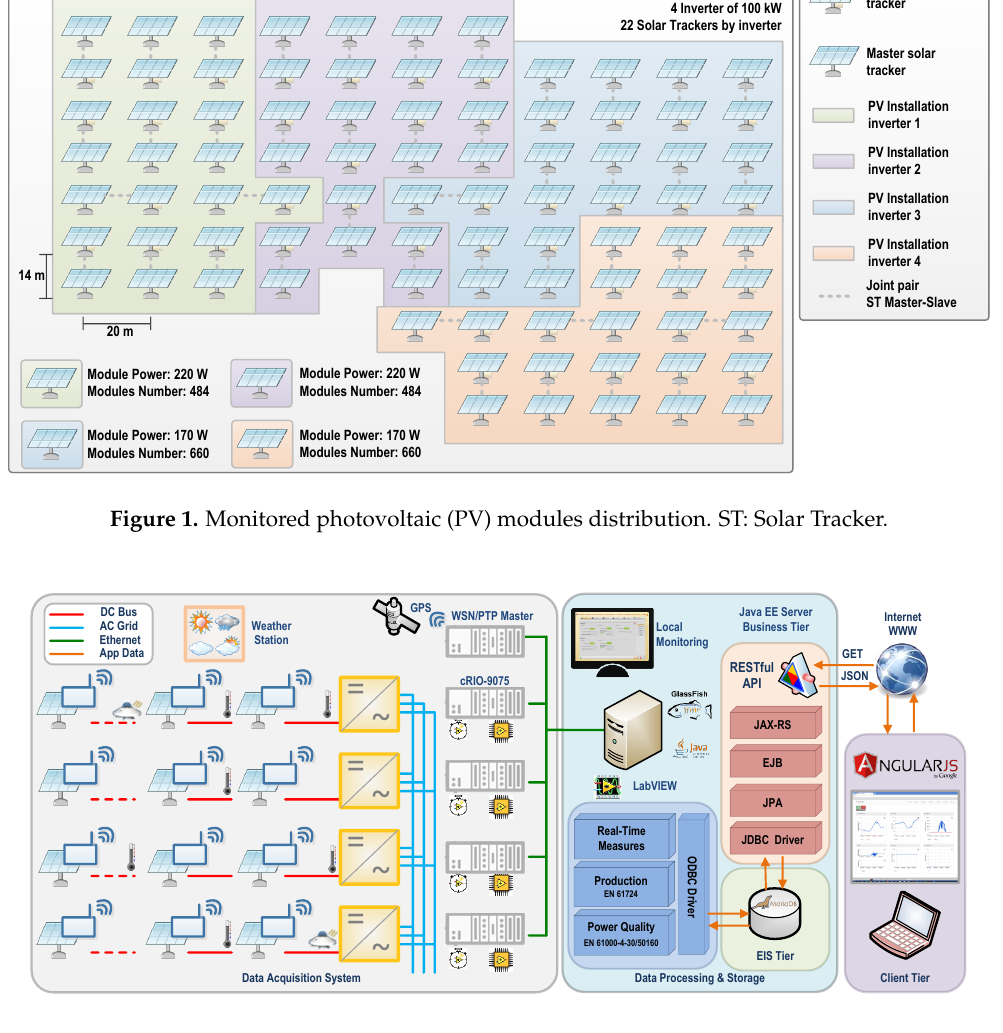
Figure 2. Schematic structure of the real-time monitoring system. Devices, conceptual blocks, communications, and information flow. EIS: Enterprise Information System; EJB: Enterprise Java Beans; JAX-RS: Java API for RESTful Web Services; JDBC: Java Database Connector; JPA: Java Persistence API; JSON: JavaScript Object Notation; ODBC: Open Database Connectivity; PTP: Precision Time Protocol; RESTful: Representational State Transfer; WSN: Wireless Sensor